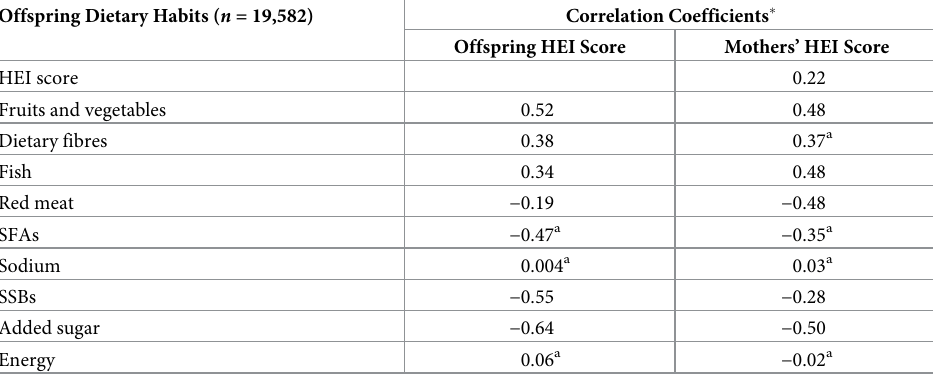
Table 4. Correlation coefficients between the HEI and offspring dietary intake.